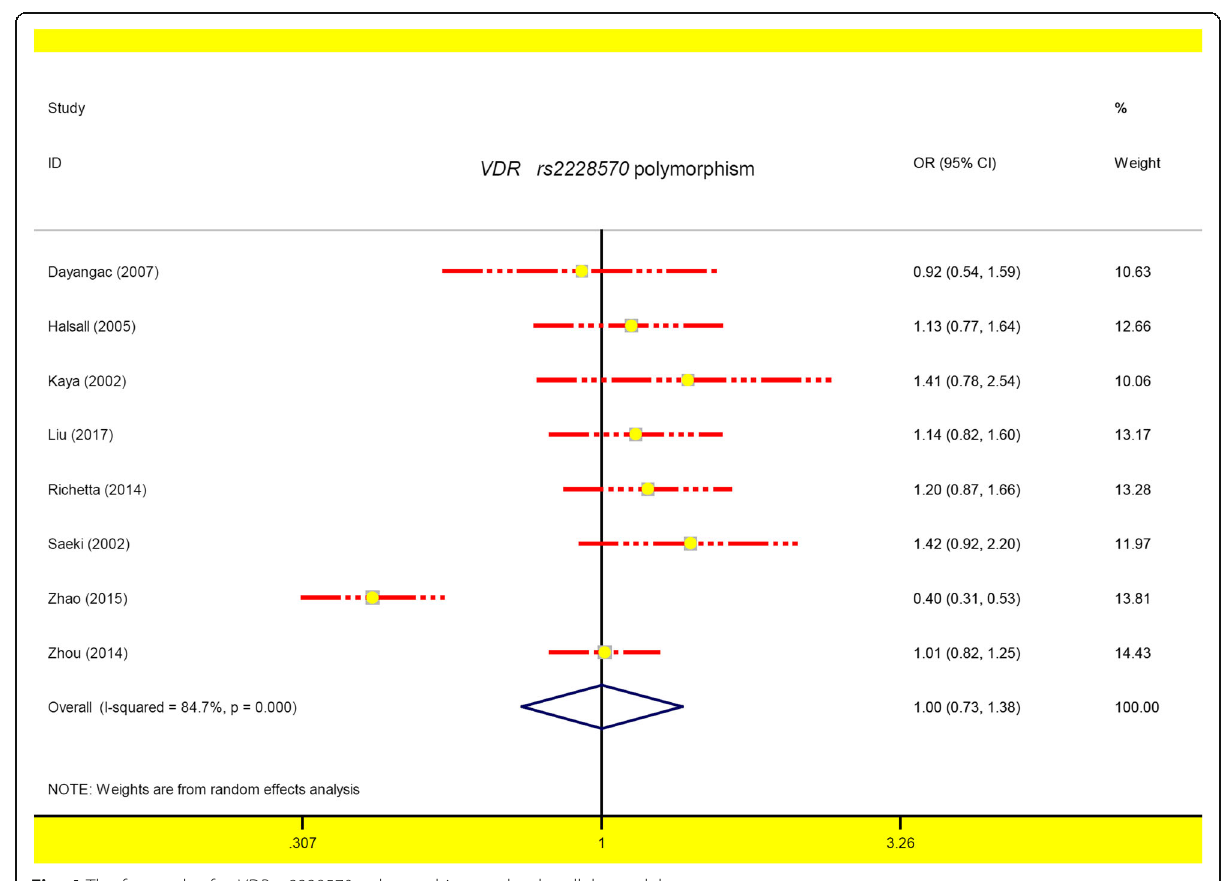
Fig. 4 The forest plot for VDR rs2228570 polymorphism under the allele